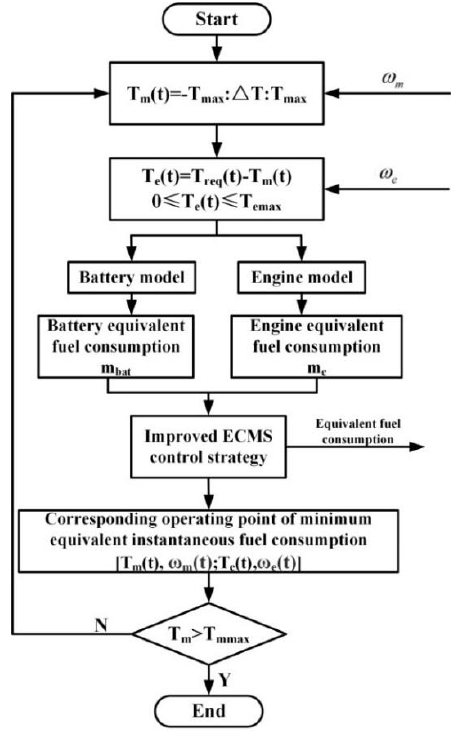
Figure 8. Improved ECMS solution flow chart.